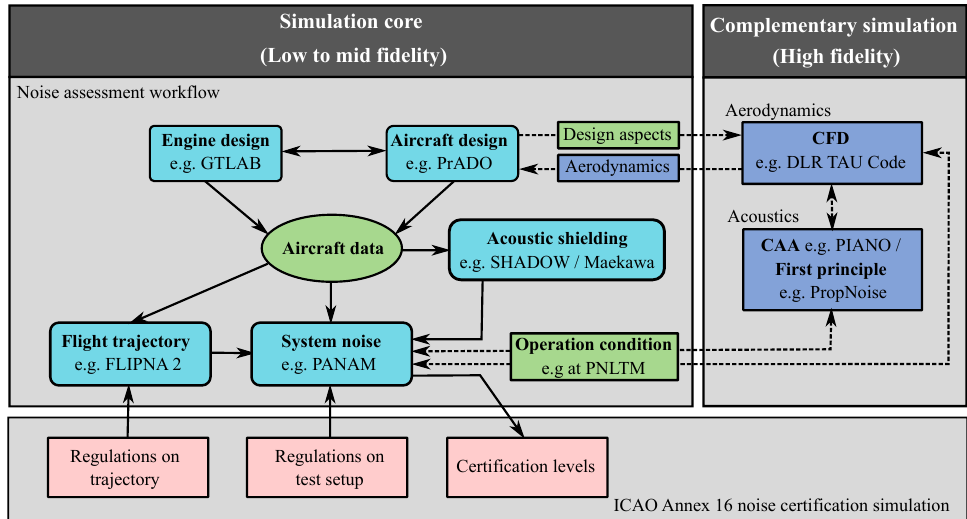
Figure 2. Process chain with simulation core for assessment of noise certification of supersonic aircraft (low to mid fidelity) and interfaces to complementary simulations (high fidelity). Extension of the illustration from Ref.